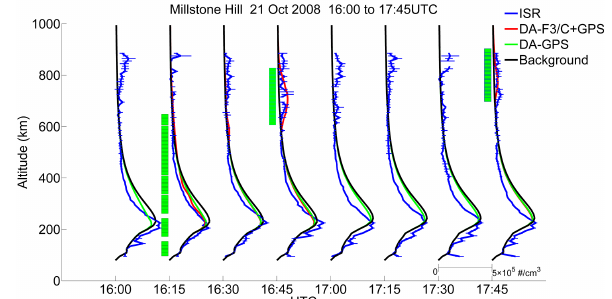
Figure 6. Comparison of data assimilation results and Millstone Hill incoherent scatter radar observations from 16:00 to 17:45UTC, with a time period of 15min. The red line is the DA electron density located at Millstone Hill and the green line is the DA electron den- sity assimilating only ground-based GPS data, while the black line is the background of the DA model. The blue line is the observation and error bars of Millstone Hill incoherent scatter radar. The green boxes indicate that the altitude had F3/C RO passing through.